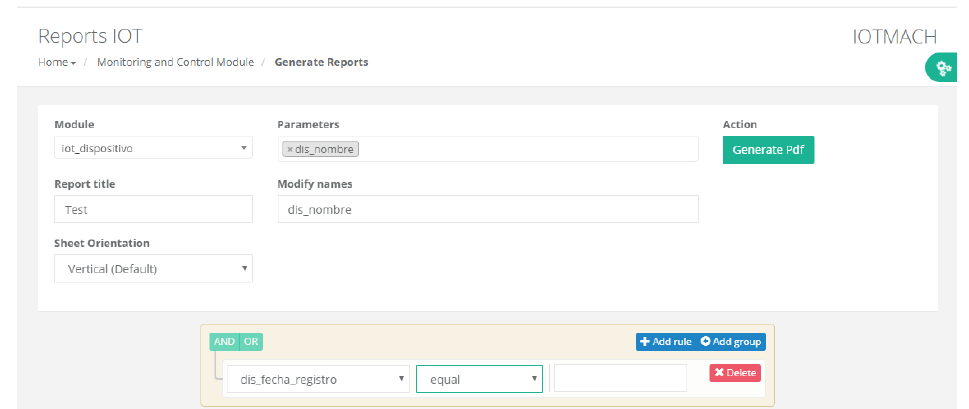
Figure 24. General view tree.